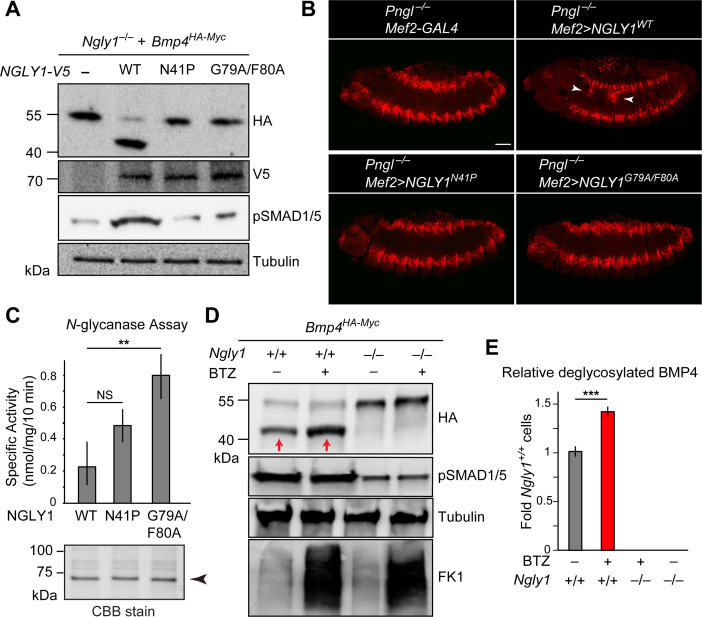
ER recruitment of NGLY1 is required for BMP4 deglycosylation and signaling in MEFs and Dpp signaling in Drosophila embryonic midgut.(A) Western blots with V5, HA and pSMAD1/5 antibodies on cell lysates from Ngly1–/– cells expressing BMP4HA-Myc alone or with human NGLY1V5-His6 (wild-type or VCP-binding mutants). Wild-type NGLY1 efficiently deglycosylates BMP4 (downward shift of the HA+ band) and induces robust BMP signaling (pSMAD1/5), but NGLY1 with mutations in its VCP-binding sites fail to deglycosylate BMP4 and induce BMP signaling. (B) Projection views of confocal image stacks of stage 14 embryos with indicated genotypes stained for pMad. Expression of wild-type human NGLY1 in mesoderm rescues BMP signaling in the midgut region (arrowheads), but the VCP-binding mutant versions of human NGLY1 do not rescue this phenotype. (C) Coomassie Brilliant Blue (CBB) stain of recombinant wild-type and VCP binding mutant (N41P and G79A/F80A) NGLY1V5-His6 proteins generated in wheat germ cell-free system and deglycosylation activity assays on these proteins. Note that the VCP-binding mutants are stably expressed (arrowhead) and do not decrease NGLY1’s enzymatic activity. One-way ANOVA with Tukey's multiple comparisons test was used. Mean ± s.d. **p<0.01; NS, not significant. (D) Western blot of HA-tagged BMP4 from cell lysates of WT and Ngly1–/– MEFs treated with bortezomib (BTZ, 10 nM for 6 hr). (E) Quantification of deglycosylated HA-tagged BMP4 expression. n = 3 biologically independent samples. Two-way ANOVA test with Tukey's multiple comparisons test was used for statistical analysis. Mean ± s.d. ***p<0.001. These results indicate that deglycosylated BMP4 is degraded by proteasome as result of ER-to-cytosol retrotranslocation. The proteasome impairment of BMP4 degradation does not block BMP signaling.Figure 6—source data 1.Raw data and statistical analysis for panels C and E.